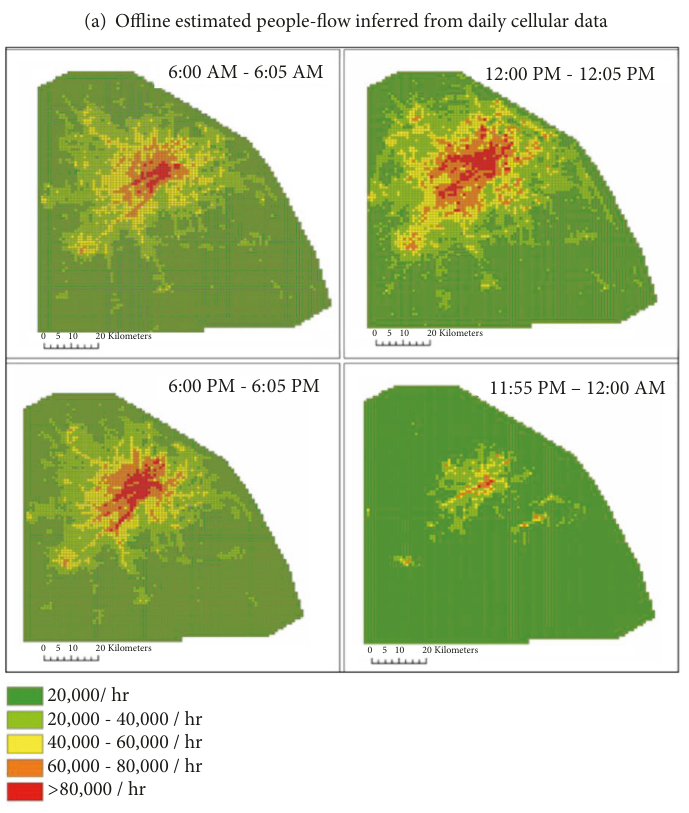
(a) Offline estimated people-flow inferred from daily cellular data